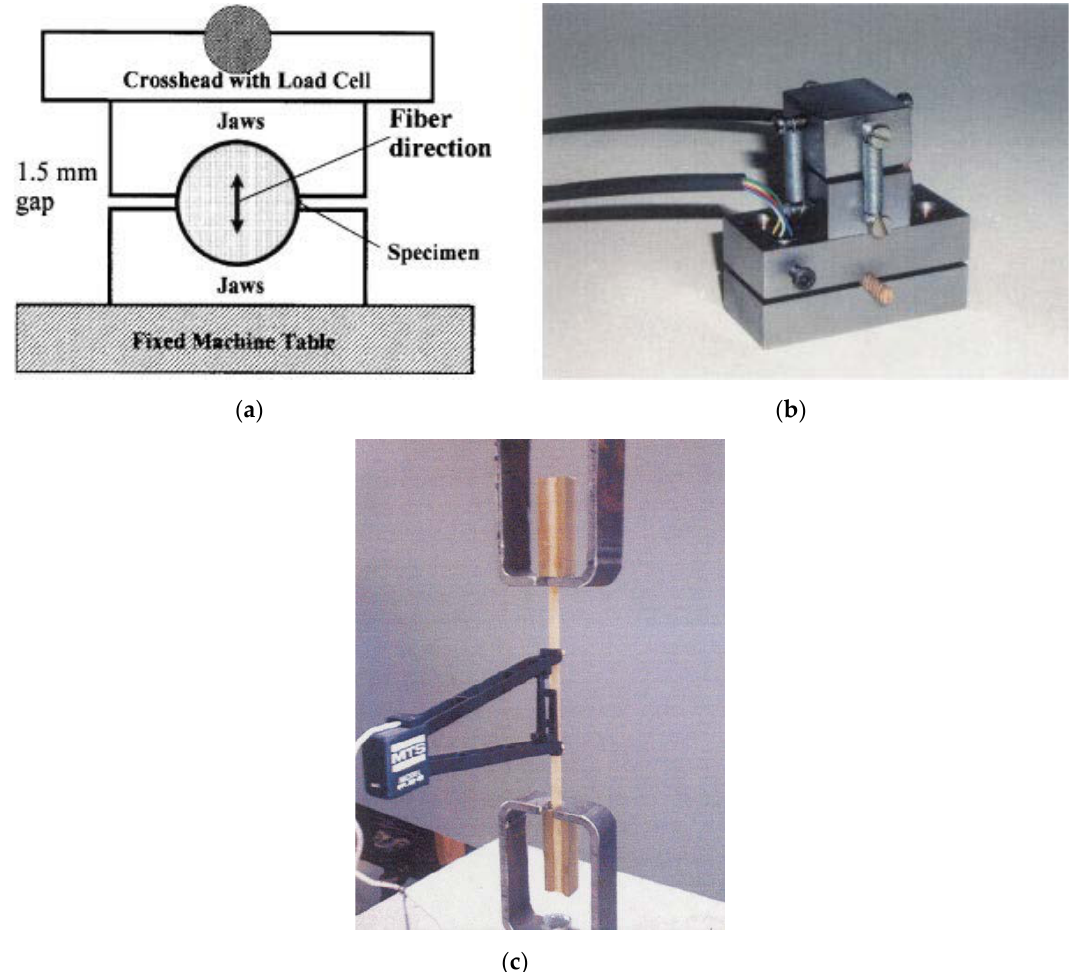
Figure 6. ( a ) Schematic drawing; ( b ) Overview of the test setup of the core-drilling technique; ( c ) Test set up of the tension micro-specimen. Reprinted from [38].